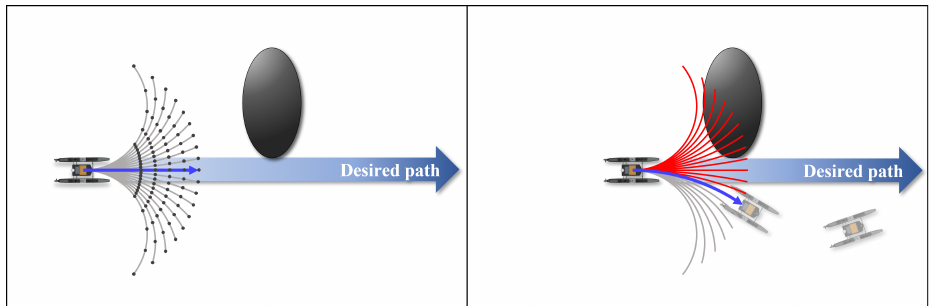
Figure 7. Schematic process of collision detection and collision